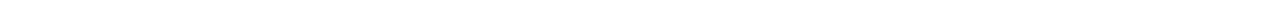
Fig. 5 Whole-brain searchlight representational similarity analysis (RSA) of multi-voxel category, value, and saliency signals. a Schematic illustration of the procedure of the whole-brain searchlight RSA. In this analysis, activation patterns in the immediate neighborhood of every voxel (a 27-voxel cube with that voxel as the center) was examined. The construction of searchlight neural representational dissimilarity matrices (neural RDMs) from multi-voxel activity patterns in response to each condition in the paradigm was based on Pearson correlational distance. The neural RDMs were then compared with candidate model RDMs based on different hypotheses. Example theoretical candidate similarity matrices based on category identity, value, and saliency are shown. The latter two candidate matrices depended on pleasantness ratings and, therefore, differed between participants. The candidate matrices from one representative participant are shown here. b – d Whole-brain maps of the z -statistic of the resemblance between the neural RDMs and each of the candidate RDMs, including category b , value c , and saliency d . Statistical thresholds for all maps were per-voxel p < 0.005 and cluster-size thresholding at FWE p < 0.05. The human brain image in a , entitled “ human brain on white background ” , by _DJ_ is sourced from https://www. fl ickr.com/photos/ fl amephoenix1991/8376271918 and licensed under CC BY 2.0 (https://creativecommons.org/licenses/by-sa/2.0/)